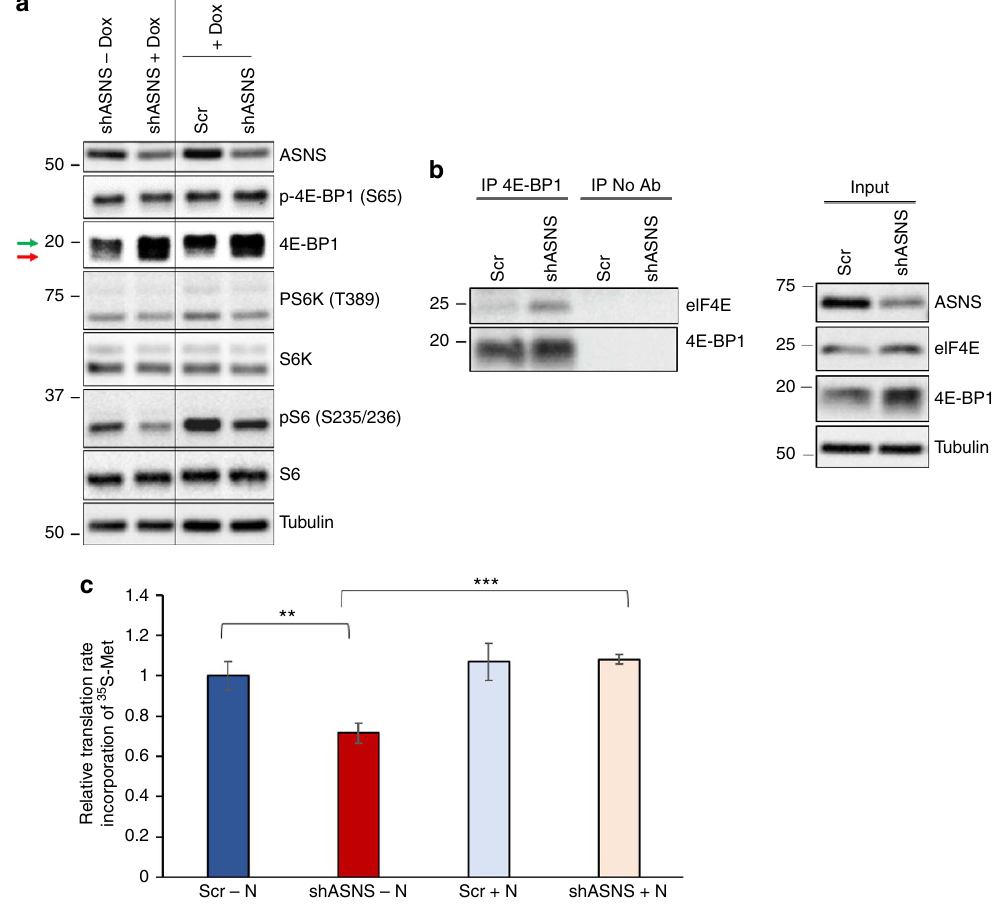
Figure 6 | Asparagine levels regulate mRNA translation. ( a ) Immunoblot of HeLa lysates with (shASNS þ Dox) and without (shASNS (cid:2) Dox) a 48-h induction of ASNS shRNA expression and HeLa lysates 48h after doxycycline induction of scrambled shRNA (Scr) or ASNS shRNA (shASNS). Lysates were immunoblotted for ASNS, phospho-4E-BP1 (S65), total 4E-BP1, phospho-S6K (T389), total S6K, phospho-S6 (S235/236), total S6 and tubulin. Green arrow indicates phosphorylated form of 4E-BP1; red arrow indicates unphosphorylated form. ( b ) Immunoblot showing levels of eIF4E and 4E-BP1 immunoprecipitated with anti-4E-BP1 antibody (left panels) and in the input lysate (right panels) from HeLa cells 48h after doxycycline induction of scrambled shRNA (Scr) or ASNS shRNA (shASNS). ( c ) Relative rates of 35 S-methionine incorporation into newly synthesized protein in HeLa cells 72h after doxycycline induction of scrambled shRNA (Scr) or ASNS shRNA (shASNS). Error bars denote s.d. of the mean ( n ¼ 3). P values were calculated by the Student’s t -test: ** P o 0.01; *** P o